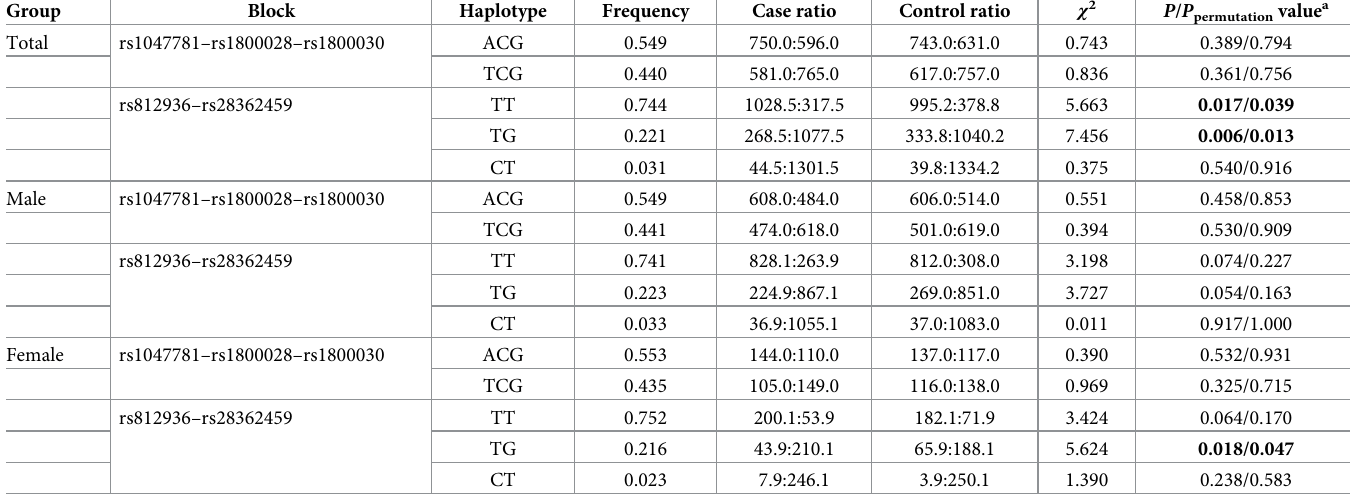
Table 3. Frequency differences in haplotypes between cases and